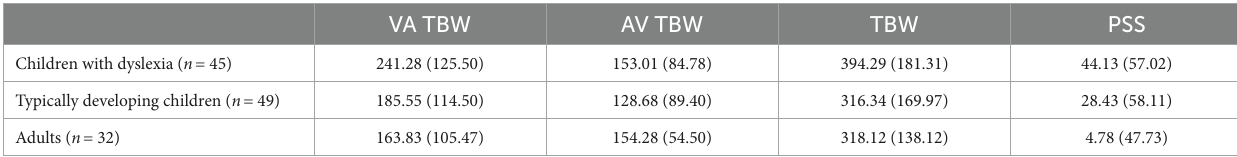
TABLE 2 The sizes of the audiovisual TBW and PSS